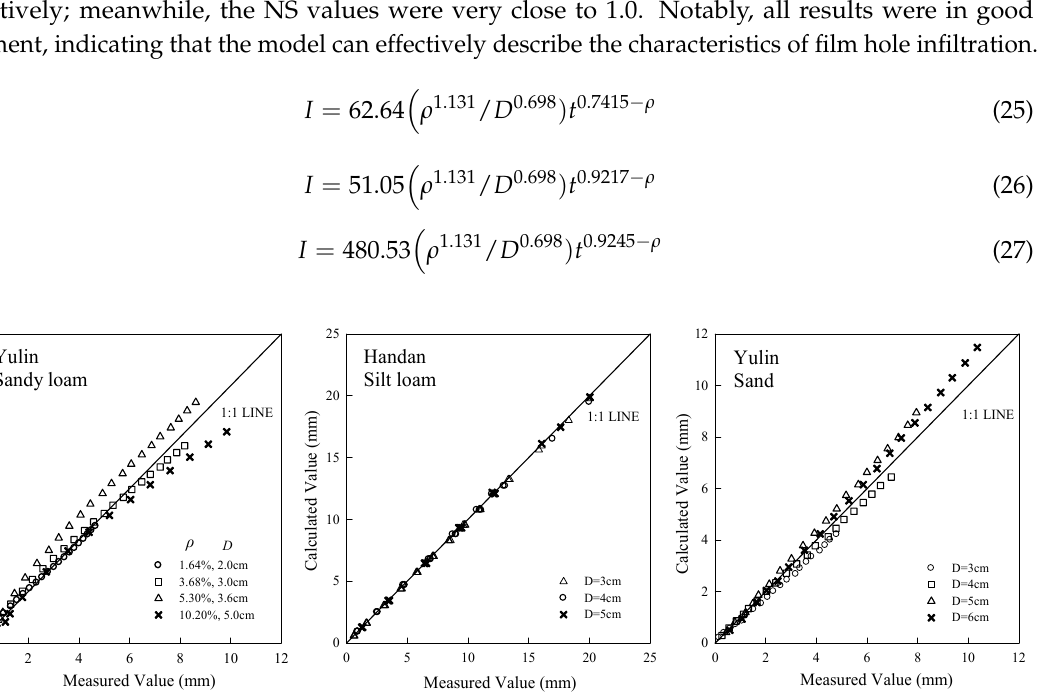
Figure 11. Comparison of four soil types between calculated values and measured values of cumulative infiltration.